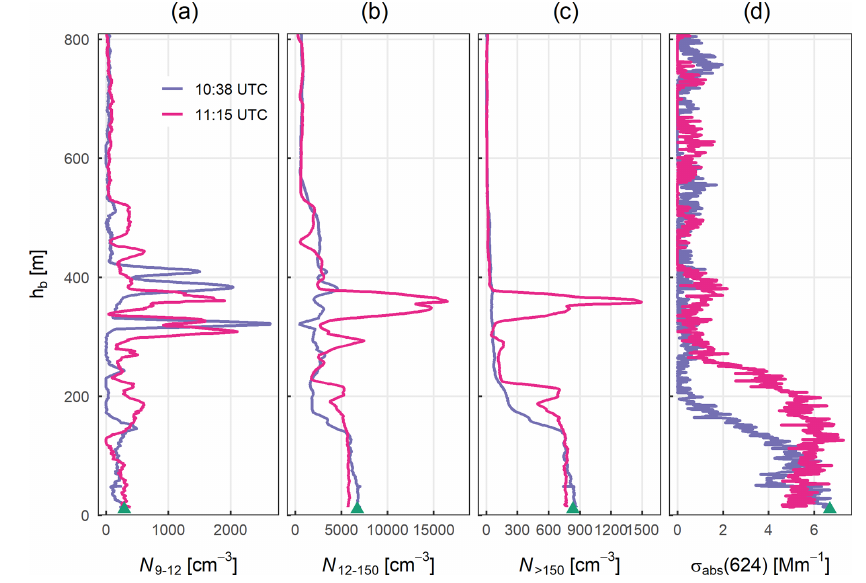
Figure 11. Same as in Fig. 10 observed during the second balloon flight in Melpitz on 15 February